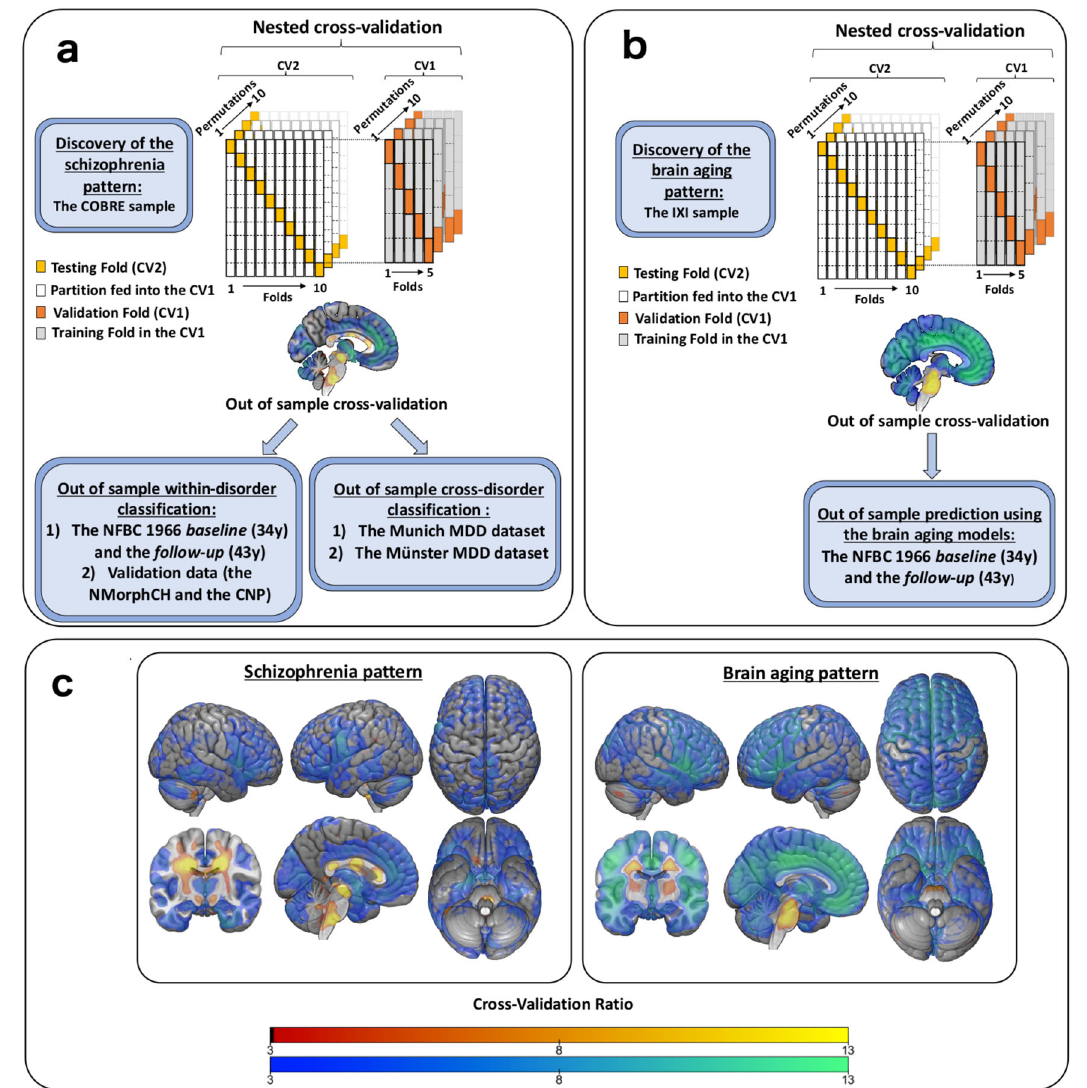
Fig. 1 Flowchart depicting the analyses of the study. a Training the schizophrenia vs. controls classi fi er in the COBRE. The classi fi er was applied, without any in-between retraining, to schizophrenia samples to assess within-disorder and MDD samples to assess cross-disorder performance. b Training the brain aging regressor in the IXI. The models were then applied to the NFBC1966 without any in-between retraining. c The visualization of the schizophrenia vs. controls classi fi er and brain aging regressor as cross-validation ratio maps. Warm colours indicate signal increases, and cold colours signal decreases in VBM